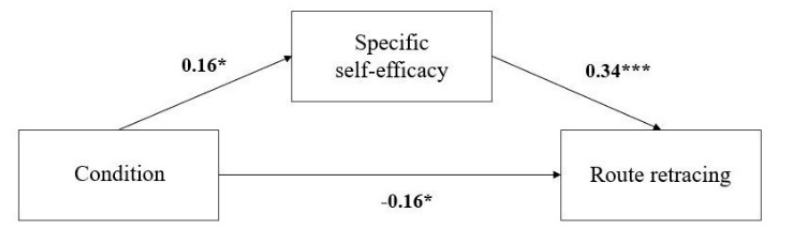
Figure 3. Mediation models of the effect of positive feedback on performance in route retracing. * p < 0.05; *** p < 0.001.